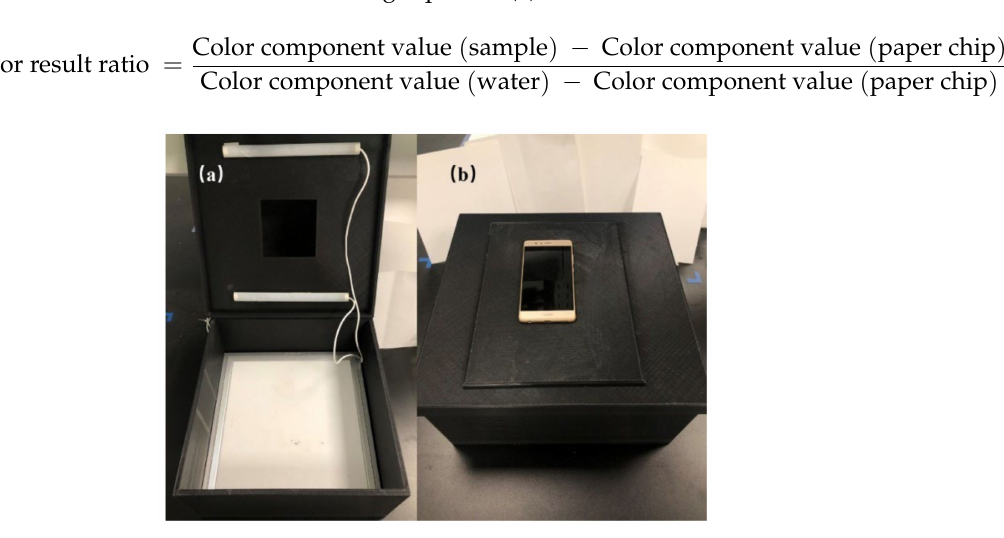
Figure 4. The 3D-printed color detection box. ( a ) Internal structure of device; ( b ) The box worked with the